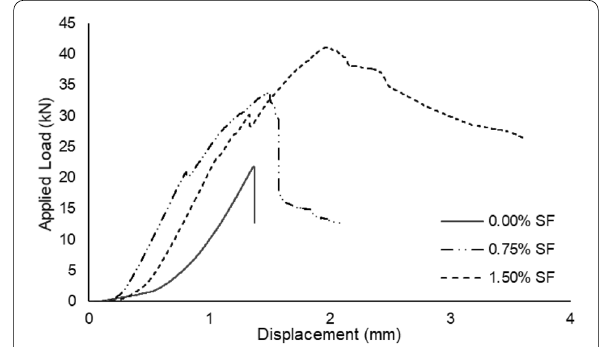
Fig. 4 A typical force/displacement plot